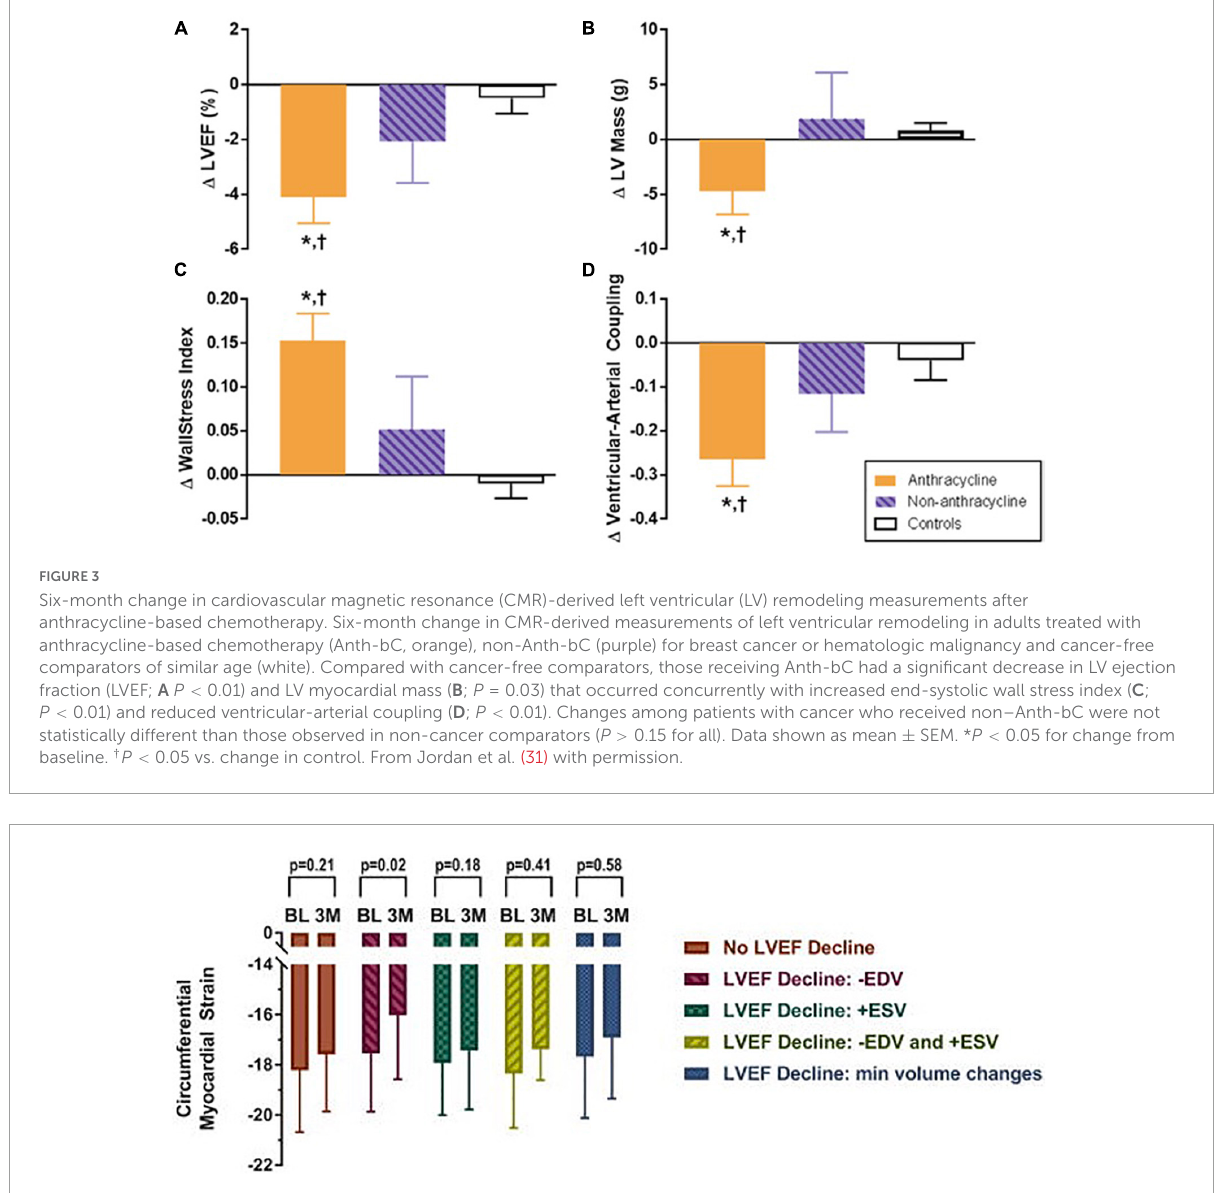
FIGURE4 Mid-wall circumferential myocardial strain measured with CMR in cancer patients prior to (BL) and 3 months (3M) after initiation of chemotherapy categorized by underlying cause for left ventricular ejection fraction (LVEF) decline. Participants with a decline in LVEF due to a > 5 ml decrease in end diastolic volume exhibited subclinical deteriorations in myocardial strain. Myocardial strain changes were not observed in any other subgroup, including those with end systolic volume changes. From Jordan et al. (37) with